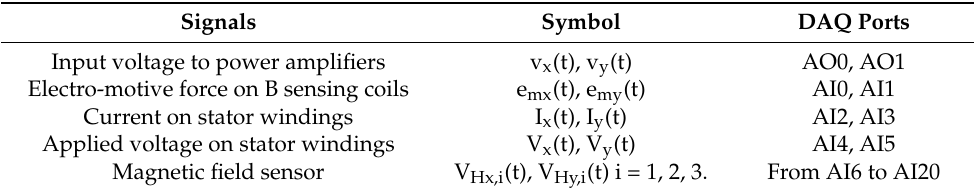
Table 1. Signals generated and measured by the DAQ in the single disk tester